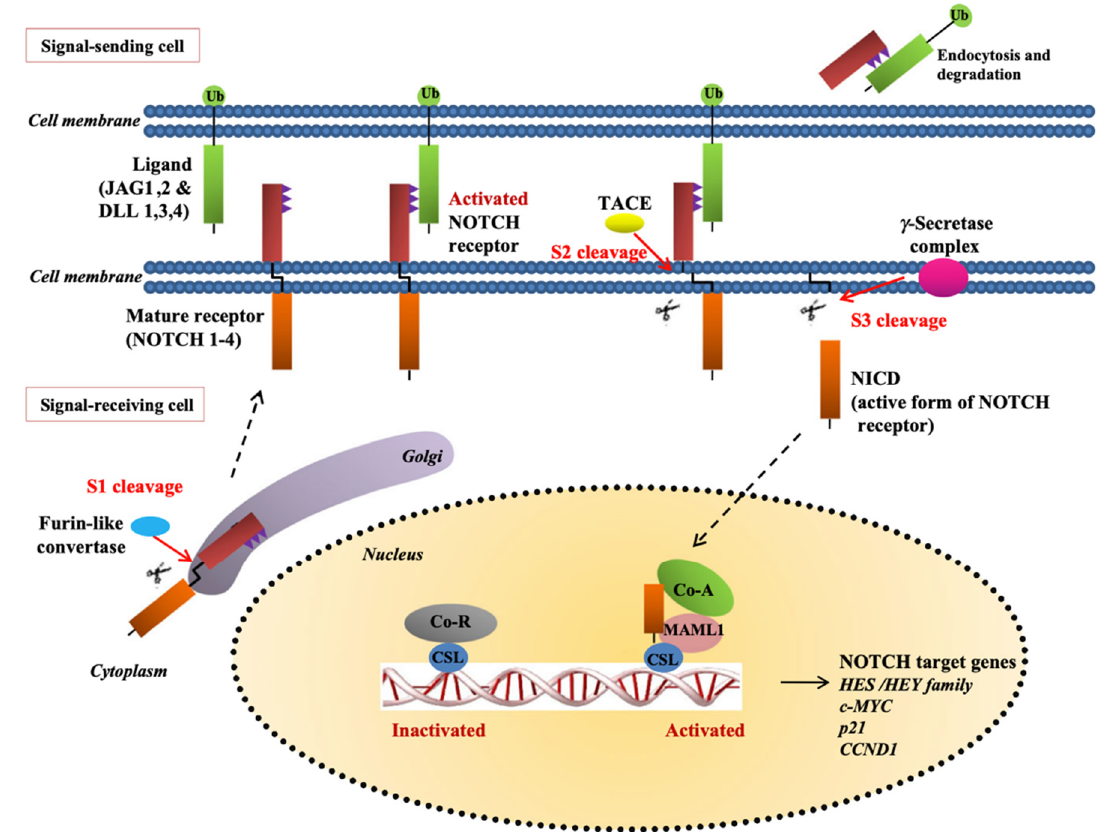
Figure 2. The notch pathway. Construction of the receptor in the endoplasmic reticulum and Golgi is followed by cleavage of NECD from TM-NICD with the converting enzyme TACE. The processed NECD is endosome-transported in the-signal sending-cell plasma membrane where it is recycled. γ -secretase releases NICD from TM in the signal-receiving cell and the NICD part enters nucleus and with the activation of CSL transcription factor complex allows nuclear translocation resulting in activation of the canonical notch target genes (Permission by Yap LF, Lee D, Khairuddin A, Pairan MF, Puspita B, Siar CH, Paterson IC. The opposing roles of NOTCH signaling in head and neck cancer: a mini review. Oral Dis. October 2015;21(7):850-7. doi: 10.1111/odi.12309. Epub 2015 Jan 29. PMID: 25580884). Table 1. Notch signaling pathways target genes.